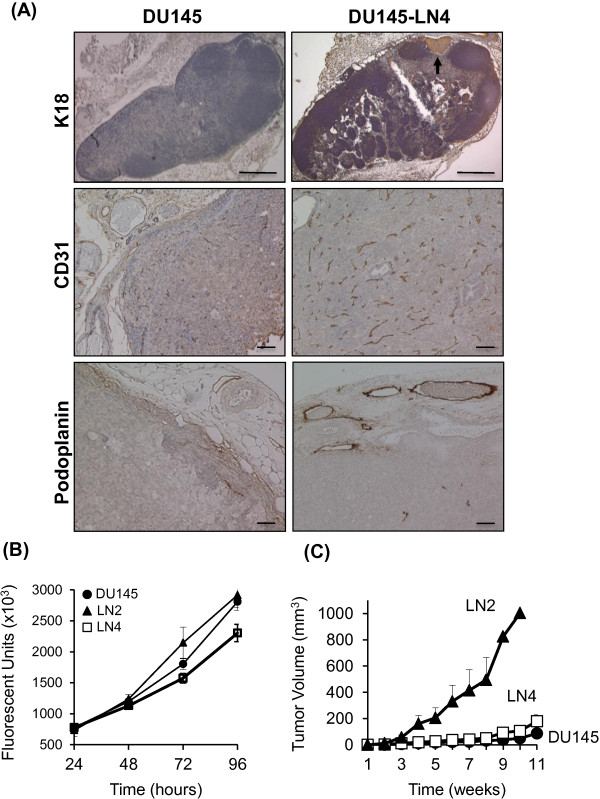
DU145 LN tumors show increased growth, angiogenesis, lymphangiogenesis, and metastasis. (A) Metastasis was measured by K18 staining of lymph nodes from mice bearing DU145 tumor (top left panel) and DU145-LN4 tumor (top right panel). K18-positive (brown color) tumor foci (arrow) were counted as positive incidence of metastasis. Scale bars = 0.5 mm. Tumor vascularization was assessed by CD31 IHC (brown color) of DU145 (middle left panel) and DU145-LN4 (middle right panel) prostate tumors. Increased vascularization was observed in DU145-LN4 tumors relative to DU145 tumors. Scale bars = 100 μm. Lymphangiogenesis was measured by podoplanin staining. Enlarged podoplanin-positive vessels (brown color) were observed in DU145-LN4 orthotopic tumors (lower right panel), compared to DU145 tumors (lower left panel). All sections were counterstained with hematoxylin (blue color). Scale bars = 100 μm. (B) In vitro proliferation assays of the DU145LN sublines indicate similar proliferation rates with slight reduced proliferation of DU145-LN4. 2.5x103 cells plated/well, absorbance measured using Cyquant dye (Ex = 485 nm). Data in arbitrary fluorescence units x1000. Filled circles: parental DU145, filled triangles: DU145-LN2, empty squares: DU145-LN4. Error bars indicate S.D. of triplicate wells. (C) DU145-LN2 shows increased tumor growth compared to parental DU145 when injected subcutaneously into nude mice. 5x106 cells were injected into the flank. Symbols as above.